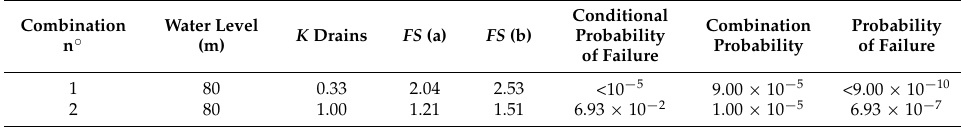
Table 9. Approach II. Results for n = 10.